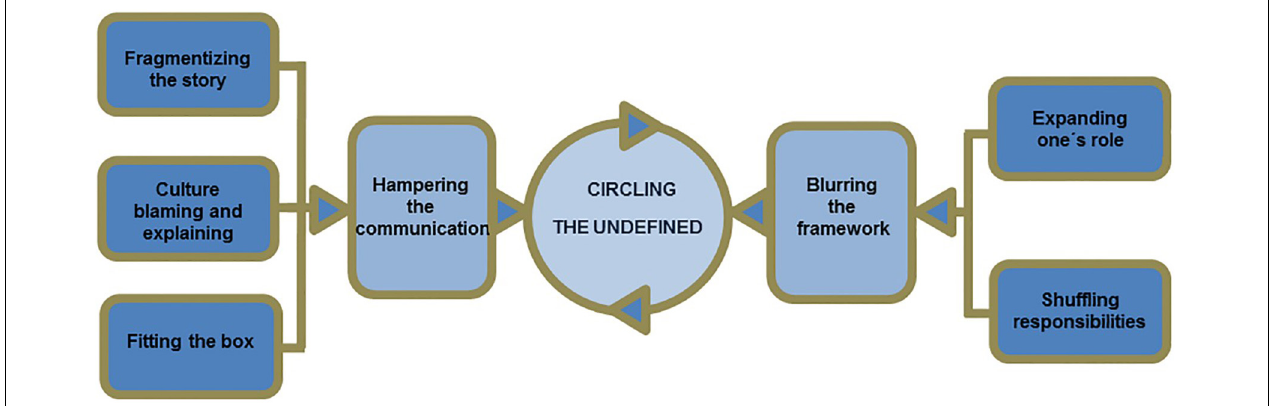
FIGURE 1 | Rothlind et al. (2018) conceptual model describing how clinicians and patients continue to ‘circle the undefined’ through their behaviours in intercultural consultations.